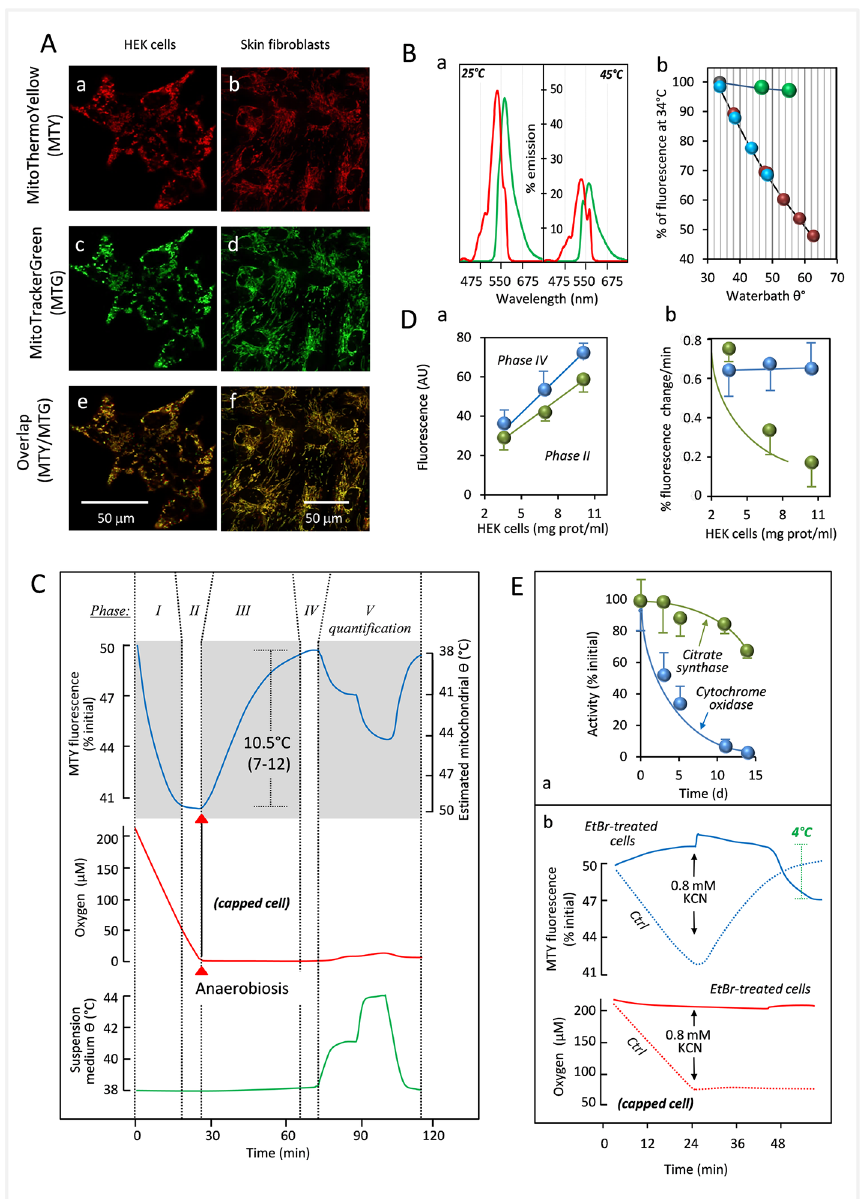
Fig 1. Determination of mitochondrial temperature in intact human cells. (A) The temperature-sensitive probe MTY (a, b) colocalizes with MTG (c, d), merge (e, f), in HEK293 cells and in primary skin fibroblasts, as indicated. (B) (a) Fluorescence excitation (red) and emission (green) spectra of MTY (1 mM) in 2 mL PBS at 25 and 45 ˚C; (b) Fluorescence response to temperature (34–64 ˚C) of MTY (blue and red) and rhodamine (green, also 1 mM) in 2 mL PBS. Note that the pseudo-linear decrease of MTY fluorescence corresponding to increasing temperature (blue) is essentially reversed upon cooling (red) of the solution to the initial temperature. (C) The definition of the various phases of fluorescence in MTY-preloaded HEK293 cells, as used in this study. Note that the initial value is given systematically as 50%, as set automatically by the spectrofluorometer (under these conditions; photo multiplier tension about 500 mV), allowing either increases or decreases to be recorded. Phase I: cell respiration (red trace) after cells are exposed to aerobic conditions in PBS, resulting in decreased MTY fluorescence (blue trace), as mitochondria heat up (cells were initially maintained for 10 min at 38 ˚C under anaerobic conditions, before being added to the cuvette). Phase II: cell respiration under aerobic conditions, in which a steady state of MTY fluorescence has been reached (maximal warming of mitochondria). Phase III: cell respiration arrested due to oxygen exhaustion—MTY fluorescence progressively increases to the starting value as mitochondria cool down. Phase IV: respiration remains stalled due to anaerobiosis; after reaching steady state, MTY fluorescence is dictated only by the water-bath temperature of 38 ˚C.